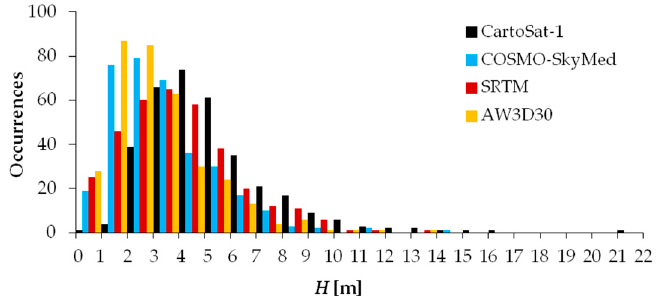
Figure 7. Distribution of height ( H ) values estimated from CartoSat-1 DSM dataset vs. the reference datasets: COSMO-SkyMed, SRTM 30 m and AW3D30.